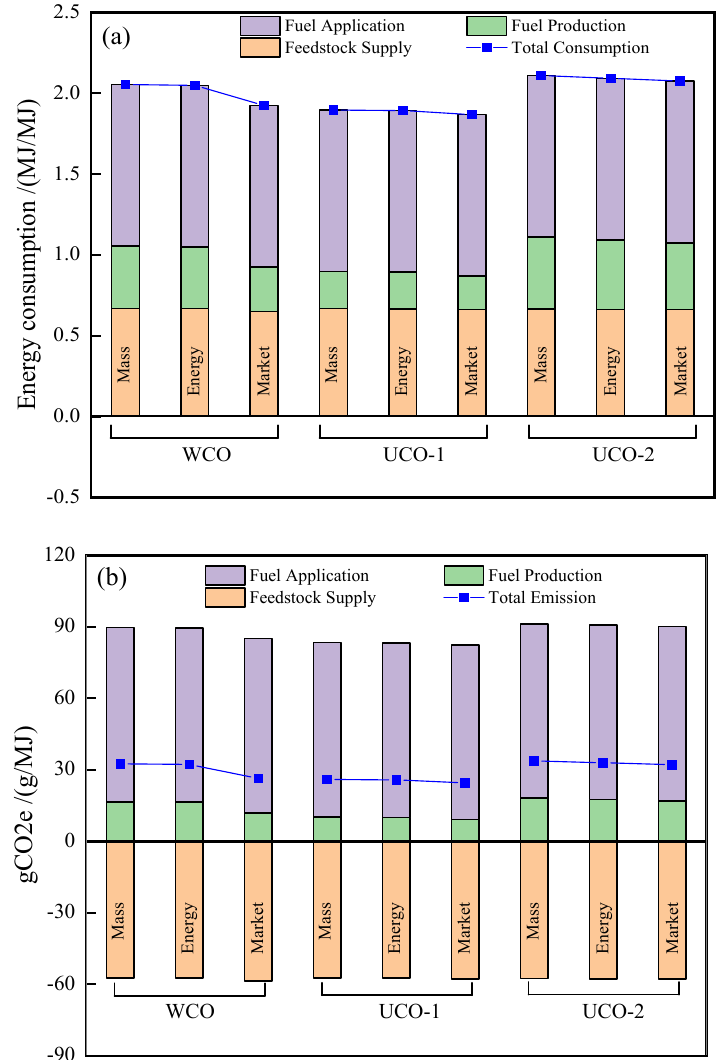
Figure 4. ( a ) Life-cycle energy consumption by different allocation methods. ( b ) Life-cycle GHG emissions by different allocation methods.